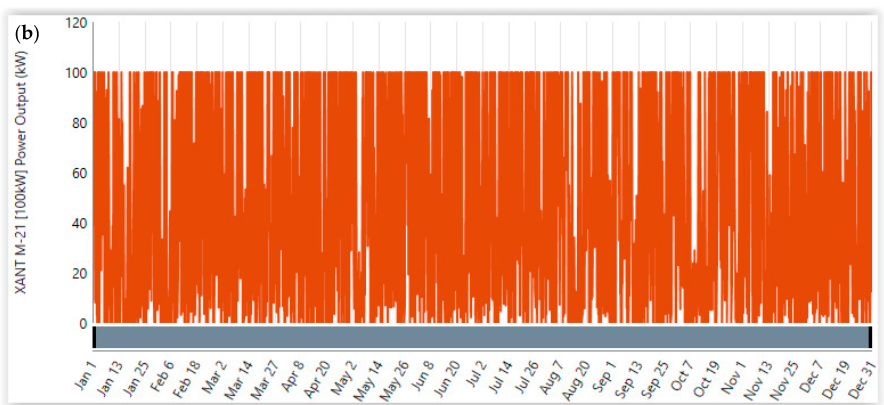
Figure 13. Power output fluctuation for ( a ) tidal turbine and ( b ) wind turbine at the Foveaux site.